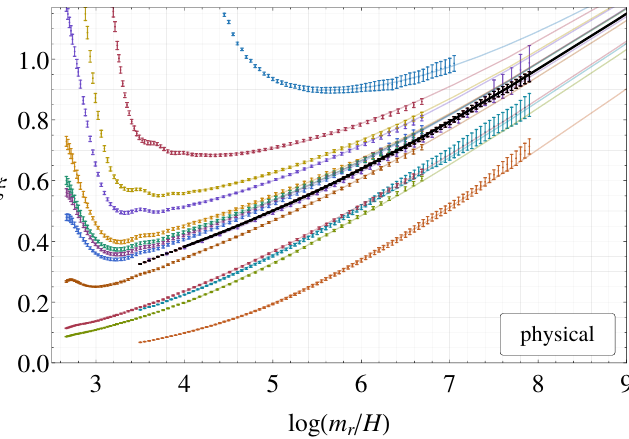
Figure 1: The evolution of the string network density ξ for different initial conditions, with statistical error bars. Different initial conditions tend asymptotically to a common attractor solution. This has an evident logarithmic increase, which would imply ξ ≈ 15 at the phys- / H ) = 60 ÷ 70. The best fit curves with the ansatz in eq. (3) are also ically relevant log ( m r shown. The initial conditions used for the analysis of the spectrum of axions emitted by the network are plotted in